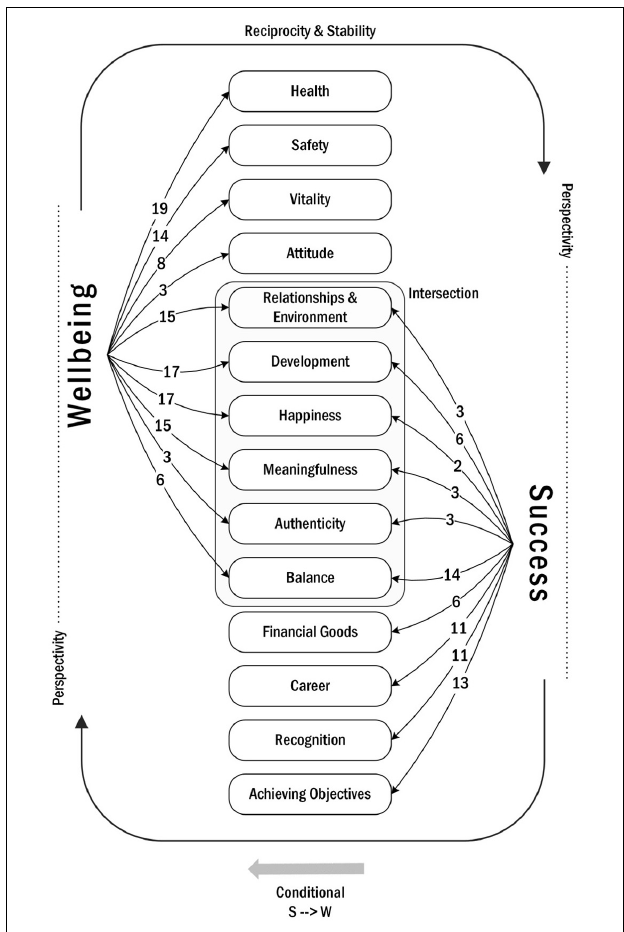
FIGURE 1 | Visualization of themes emerged from the qualitative analysis of students’